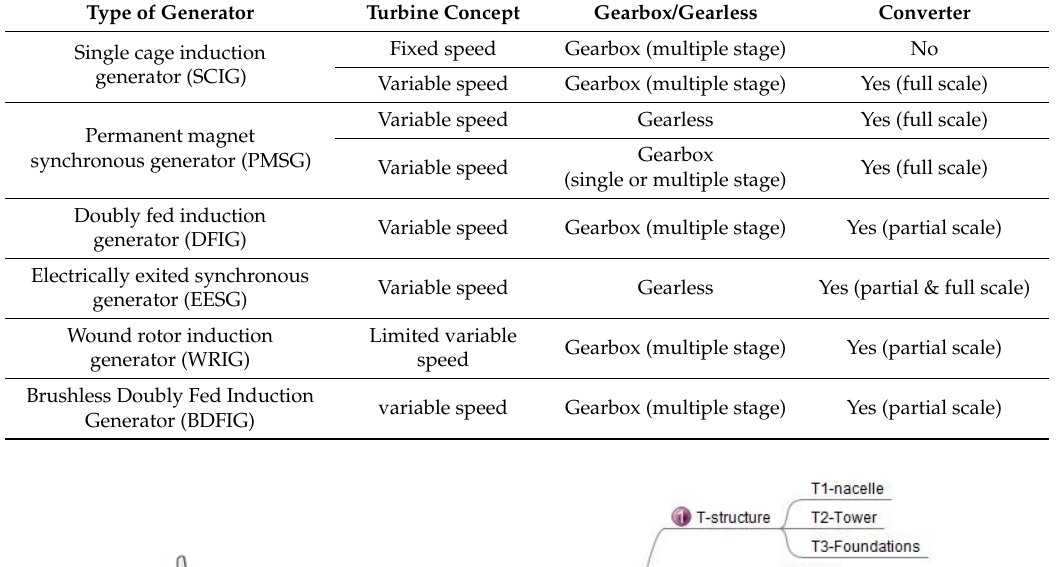
Table 3. Main existing wind turbine systems in European and French Market.